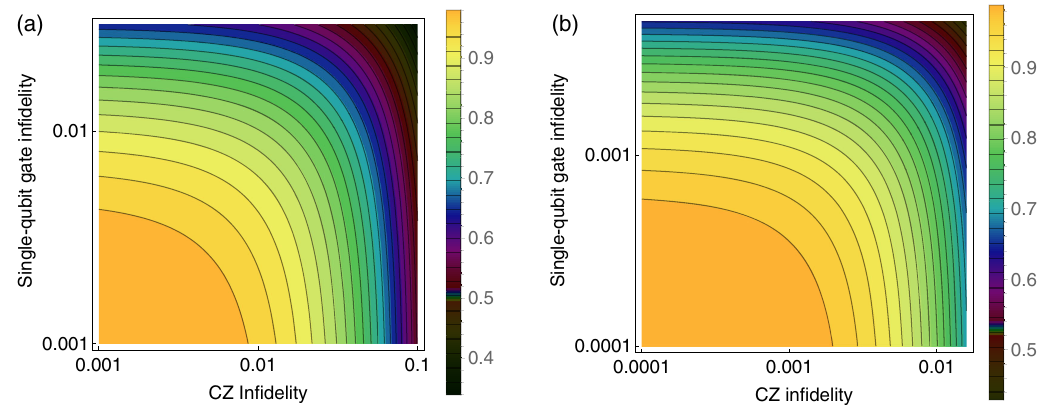
FIG. 7. (a) The fidelity of the N ¼ 6 RGS shown in Fig. 1 as a function of the infidelities of the two-qubit CZ gate and the individual single-qubit gates applied to emitters and ancillas (which are assumed to all have the same infidelity). (b) The fidelity of the large repeater state shown in Fig.